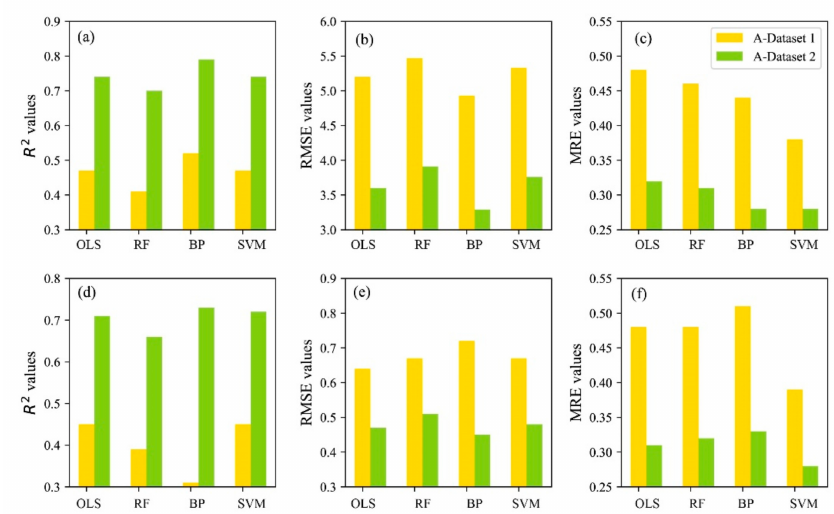
Figure 13. Comparison of the accuracy of AGB estimation for the four methods using A-Dataset 1 (Spectral information), A-Dataset 2 (fusion of spectral data and the 3D multispectral SfM point clouds (T 10 and mean)): ( a ) R 2 , ( b ) RMSE, and ( c ) MRE of fresh AGB; ( d ) R 2 , ( e ) RMSE, and ( f ) MRE of dry